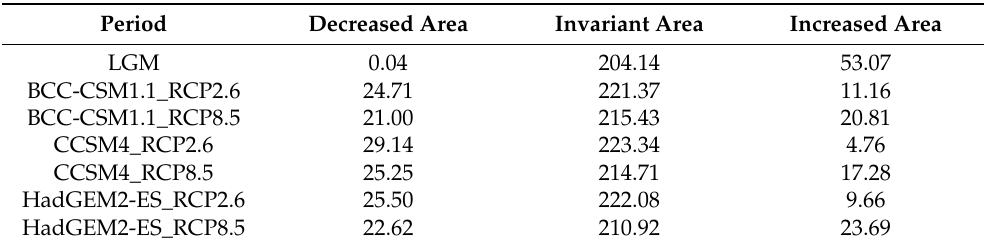
Table 5. Suitable habitat of J. tibetica in different periods ( × 10 4 km 2 ). Period Decreased